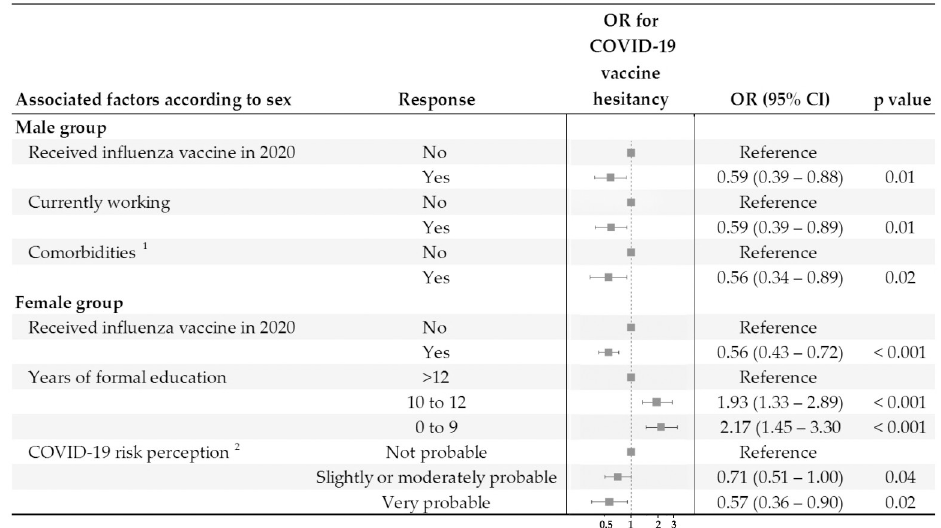
Fig 1. Sex-stratified multivariable analysis for identification of factors associated with COVID-19 vaccine hesitancy among men and among women, Salvador, Brazil, 16 November 2020–15 January 2021. 1 Comorbidities included diabetes, hypertension, and cancer. 2 Risk perception evaluated using the question: How likely are you to get COVID-19? OR: Odds Ratio.